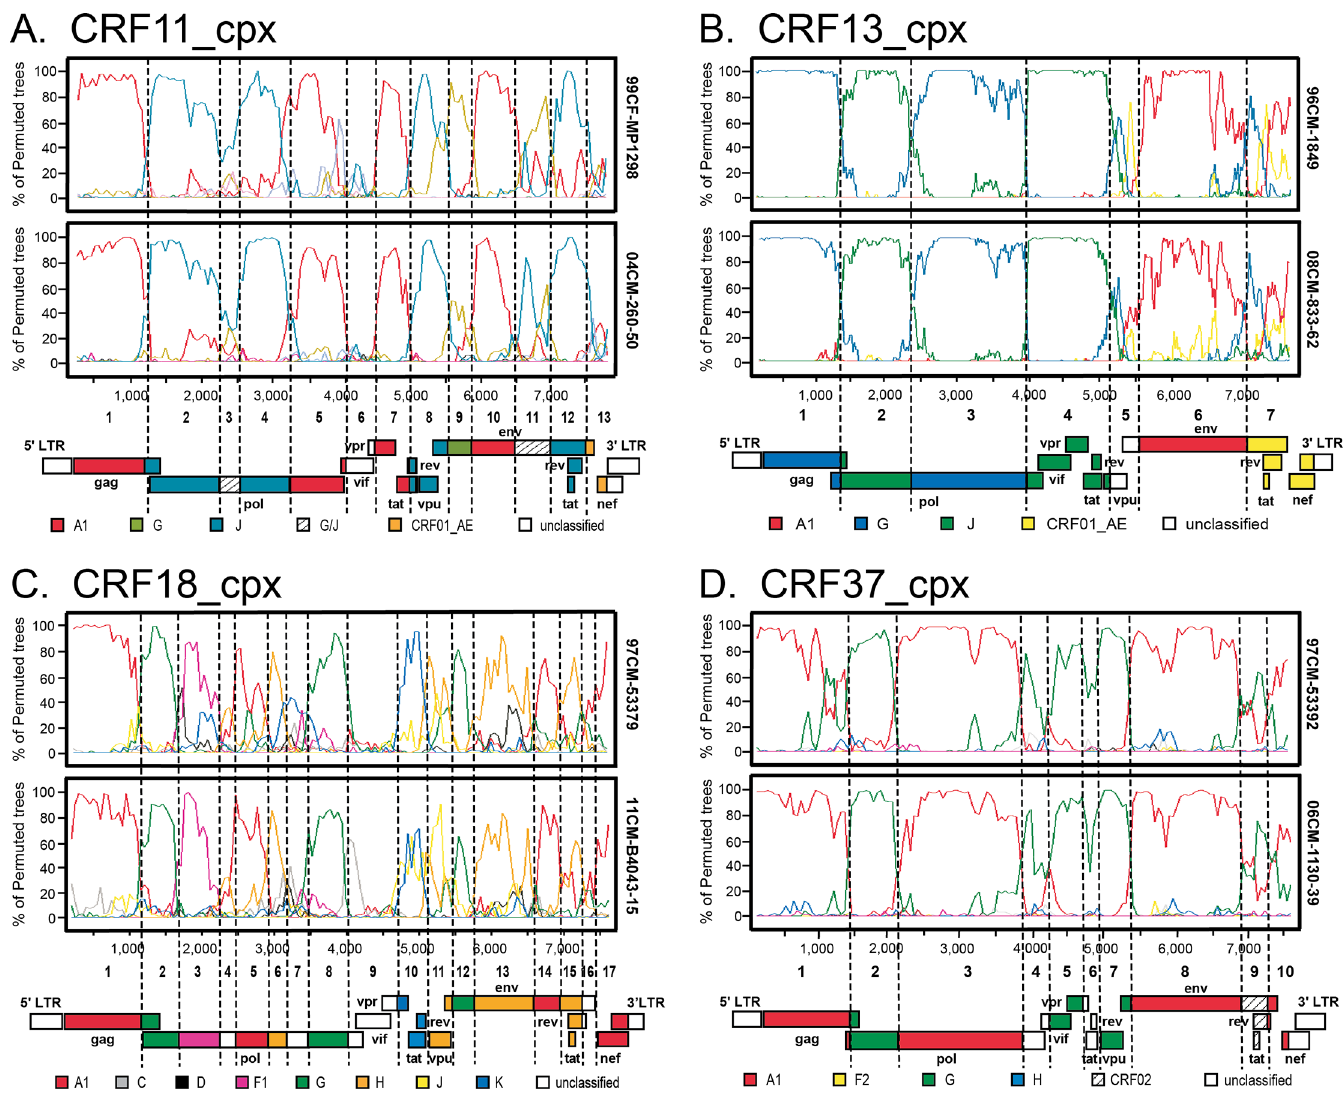
Fig 4. Breakpoint analysis for rare, complex recombinants endemic to Cameroon. Bootscan plots are shown for (A) CRF11_cpx, (B) CRF13_cpx, (C) CRF18_cpx and (D) CRF37_cpx isolates. In each panel the profile for a reference strain is shown on top and a representative new strain is on the bottom. Vertical dashed lines indicate recombination breakpoints determined by Find Site; genome structure is diagramed below each plot. Bootscan analysis was performed using a window of 400 base pairs and 20 base pair